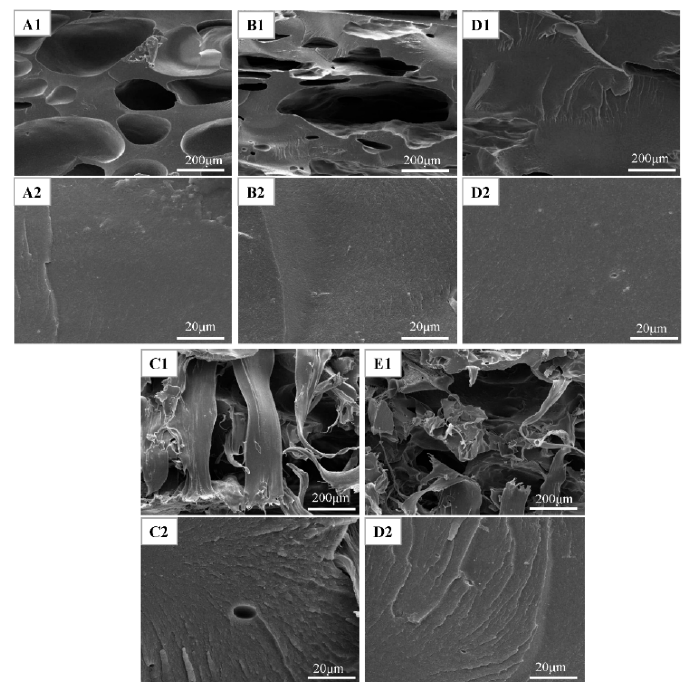
Figure 7. Fracture surface micrographs of the cured adhesive ( A1 , A2 ) (Soy protein isolate (SPI)), ( B1 , B2 ) (SPI/TGA), ( C1 , C2 ) (SPI/TGA/TPU), ( D1 , D2 ) (SPI/TGA/KH-560), ( E1 , E2 ) (SPI/TGA/KH-560/TPU).